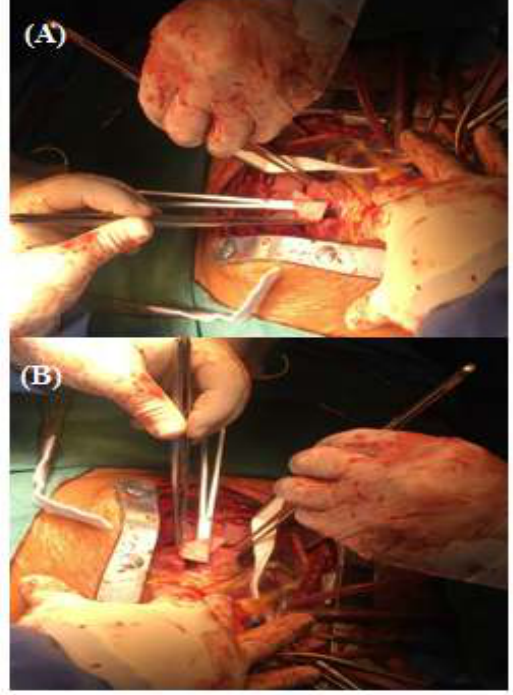
Figure 3: (A) Intraoperative bovine patch closure of VSR. (B) Teflon strips reinforced linear ventriculotomy closure.